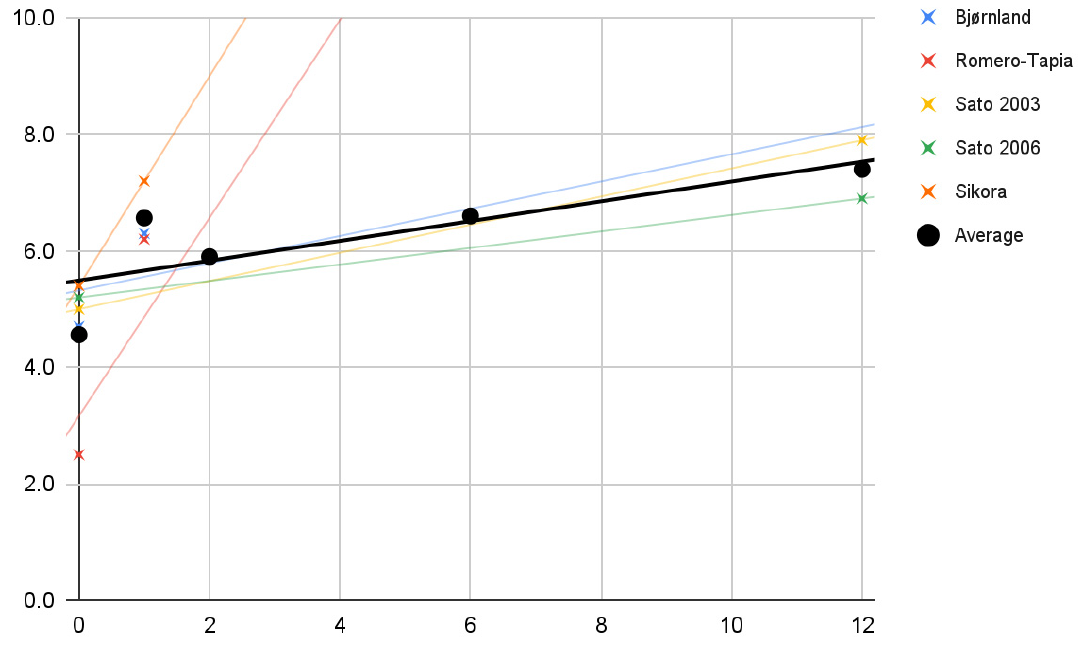
Figure 4. Changes in the range of mandibular protrusive movement (mm) over time (months). Description in the text.